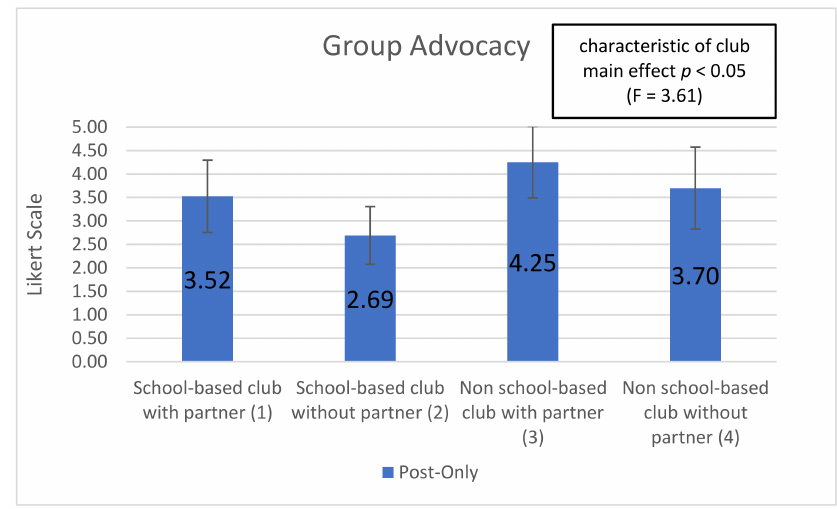
Figure 7. Group Advocacy post-assessment by club type and